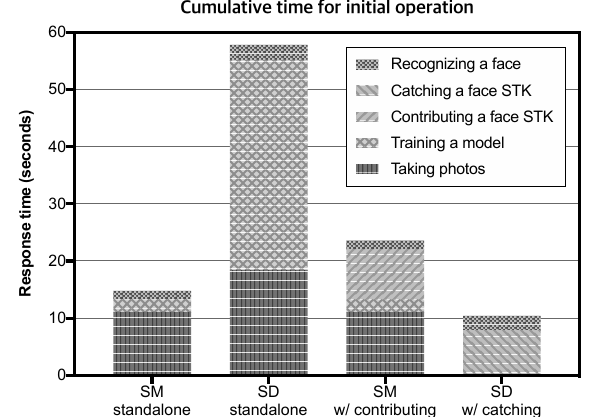
Figure 8. Comparison of initial operation time between four variants of our prototype; smart mirror (SM) standalone, smart doorbell (SD) standalone, smart mirror (SM) with STK contributing, and smart doorbell (SD) with STK